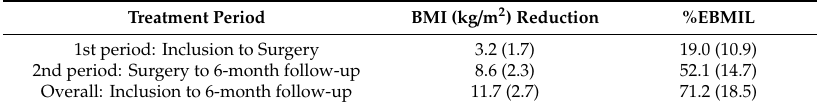
Table 2. Weight loss after the behavioural and surgical interventions in 98 subjects with a follow-up 6 months after surgery.